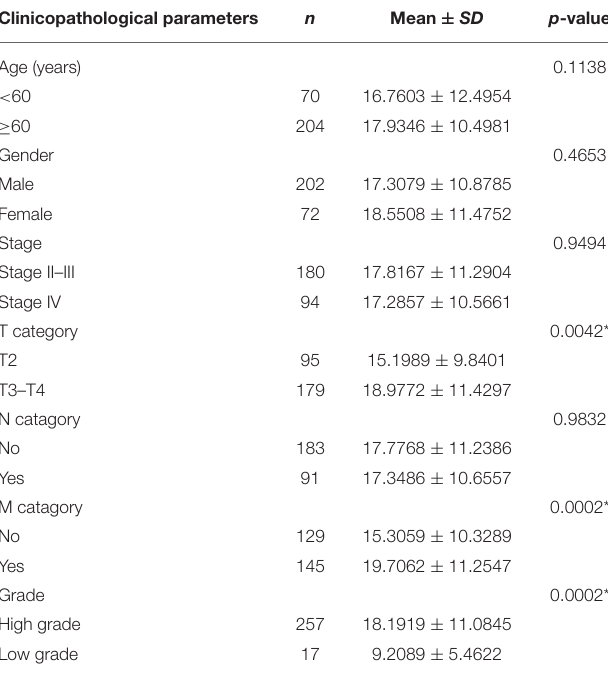
TABLE 2A | The correlations between the CORO1C and clinicopathological features based on TCGA-BLCA data. Clinicopathological parameters